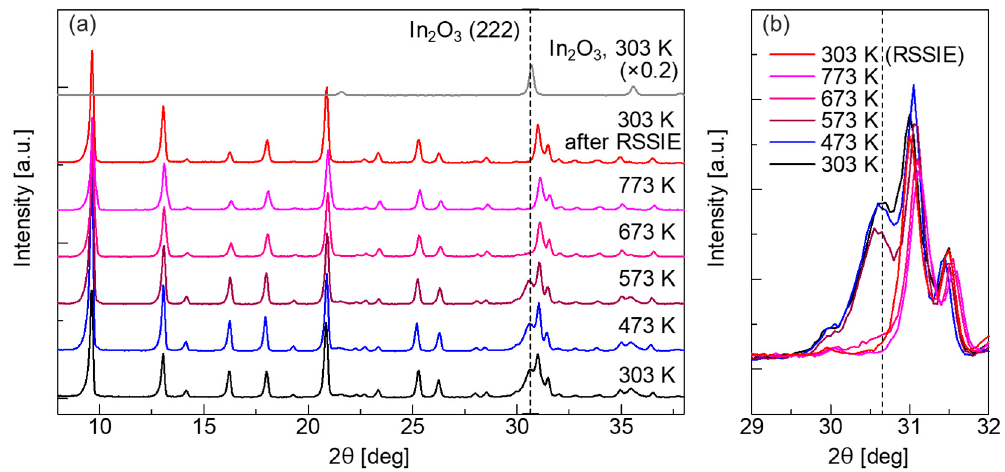
Figure 1. ( a ) In - situ X-ray diffraction (XRD) patterns during reductive solid-state ion-exchange (RSSIE) of In 2 O 3 /CHA (In/Al = 0.8) under 5% H 2 /N 2 flow at different temperatures. ( b ) Comparison of the peaks derived from In 2 O 3 (222) around 2 θ = 30.6°.